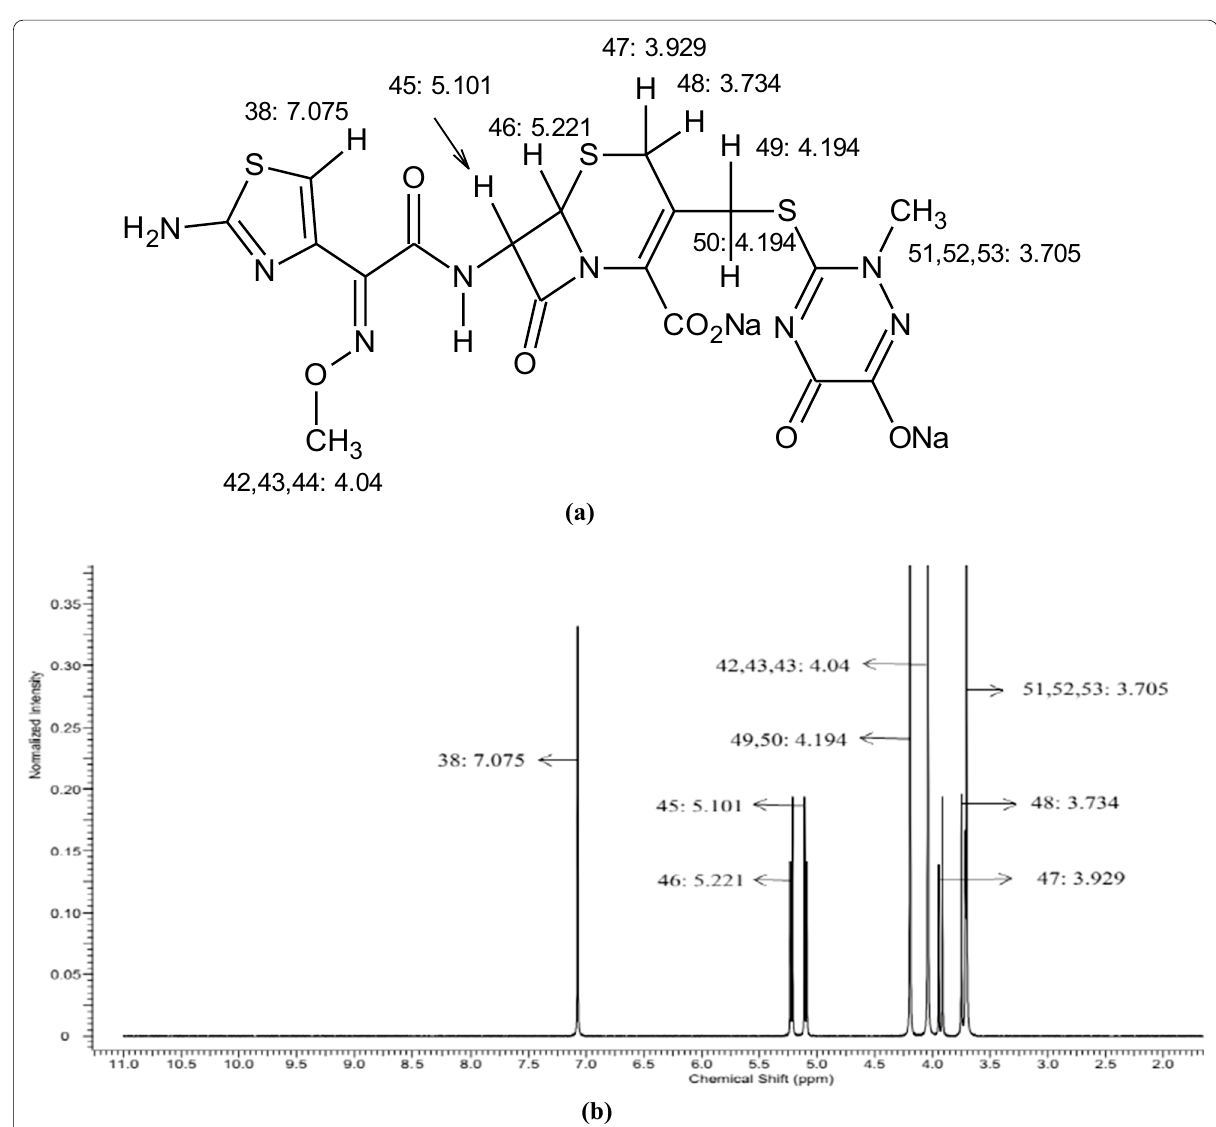
Fig. 8 a Spinus predicted chemical shifts of CFR arranged according to protons. b Spinus predicted 1 H NMR spectrum of CFR showing atom ID and chemical